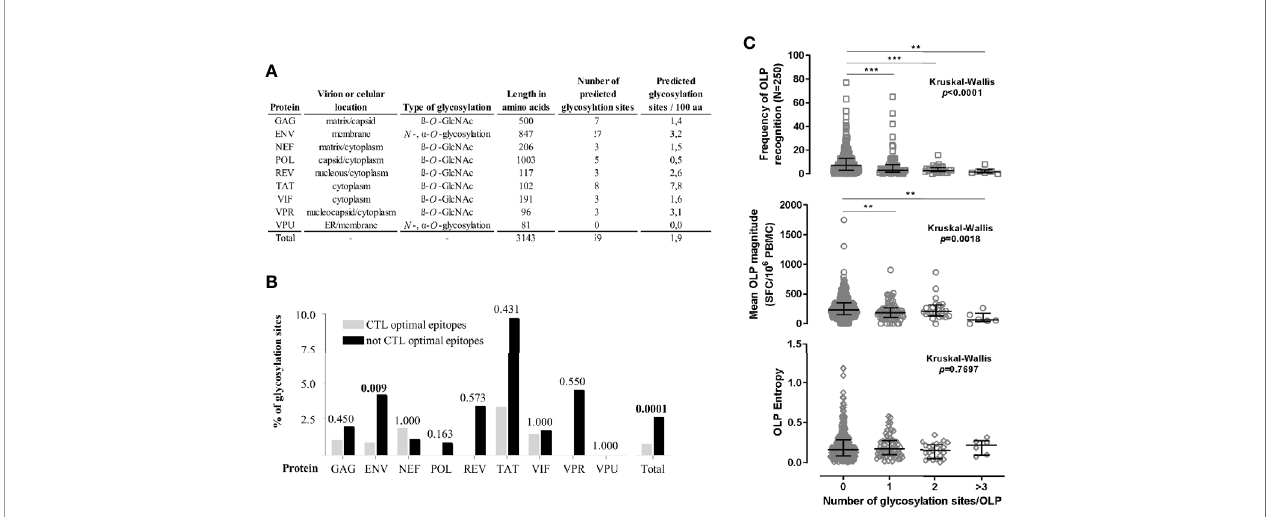
FIGURE 1 | Potential impact of glycosylation on T cell responses to HIV. (A) Predicted glycosylated positions in HIV proteins taking into account cellular location of viral proteins. (B) Percentage of predicted glycosylated sites in known, optimally de fi ned CTL epitopes (9) in comparison to regions for which no optimal CTL epitopes have been de fi ned. Frequency differences were analyzed by the Fisher exact test, p<0.05 are highlighted in bold numbers. (C) Frequency of recognition and magnitude of the response to HIV OLP in 250 HIV infected individuals strati fi ed by the number of potential glycosylations in each OLP. The existence of statistically signi fi cant differences was analyzed using the Kruskal-Wallis test, Mann-Whitney p values are indicated by * p <0.05, ** p <0.01, *** p <0.001, **** p